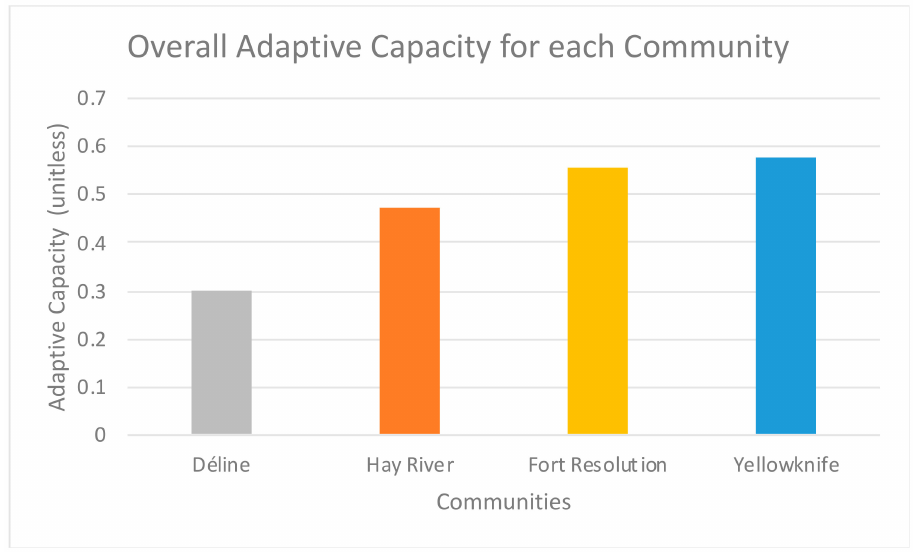
Figure 8. The overall rank of each community’s adaptive capacity as determined by the five types of capital (human capital, physical capital, financial capital, social network, natural